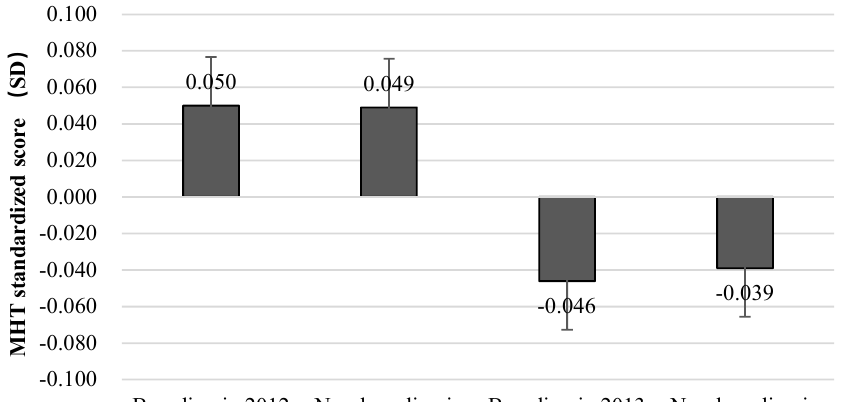
Figure 1. Mean of standardized students’ mental health test (MHT) scores.